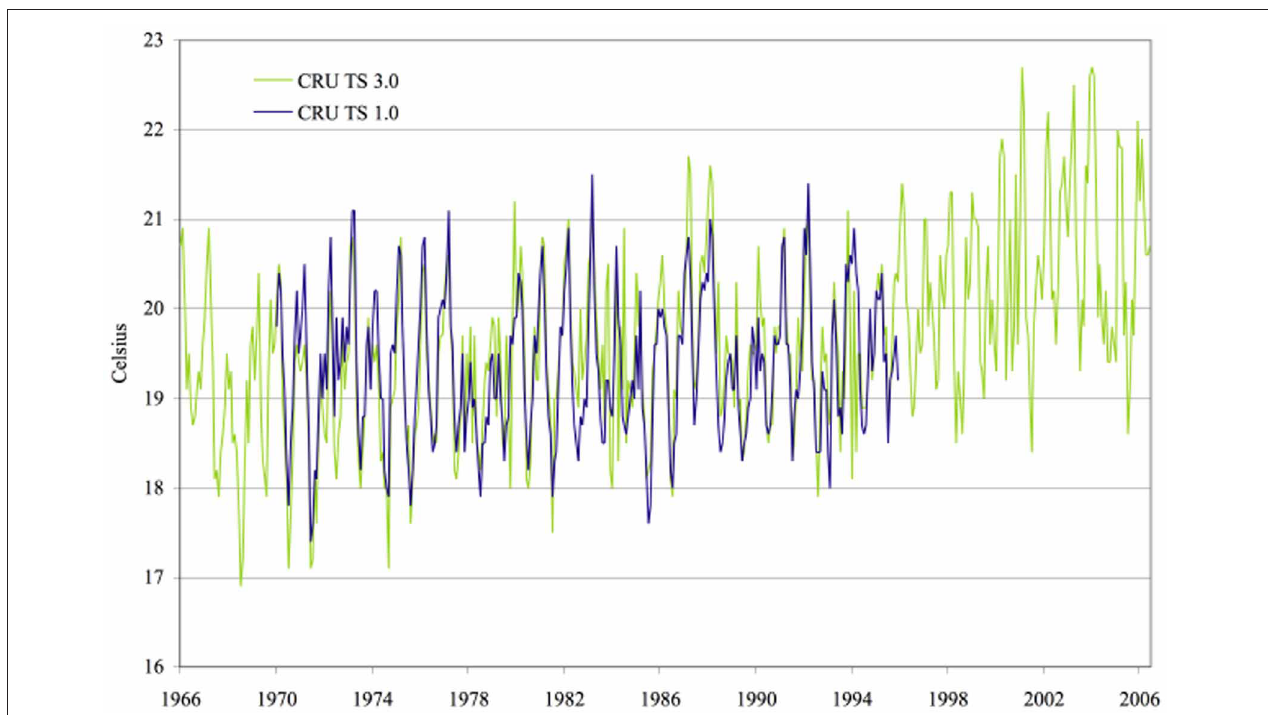
FIGURE 5 | Temperature series for Kericho: CRU TS 1.0 vs. CRU TS 3.0. Source: Stern et al. (2011), with permission from Dr. David I. Stern, Crawford School of Economics and Government, Australian National